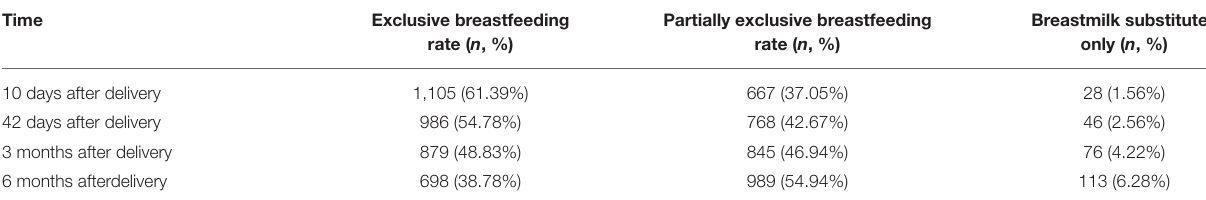
TABLE 4 | Breastfeeding investigation on full-term infants within 6